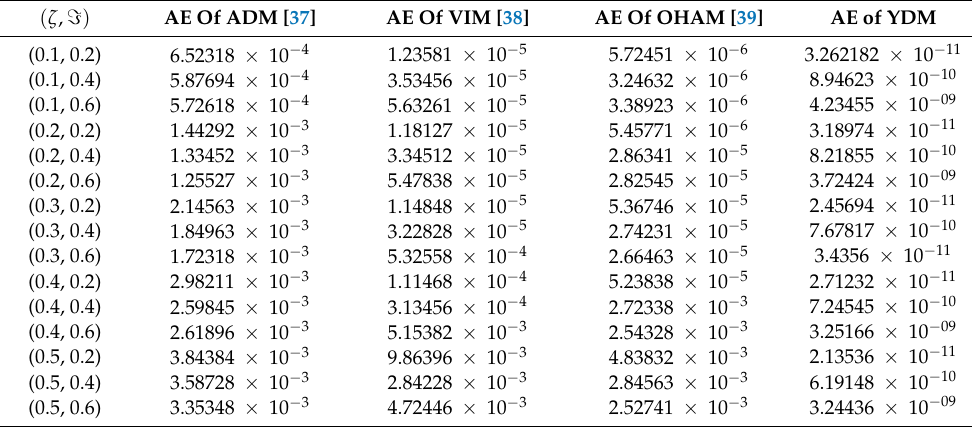
Table 4. Comparison of absolute error of V ( ε , (cid:61) ) at ℘ = 1 obtained by various